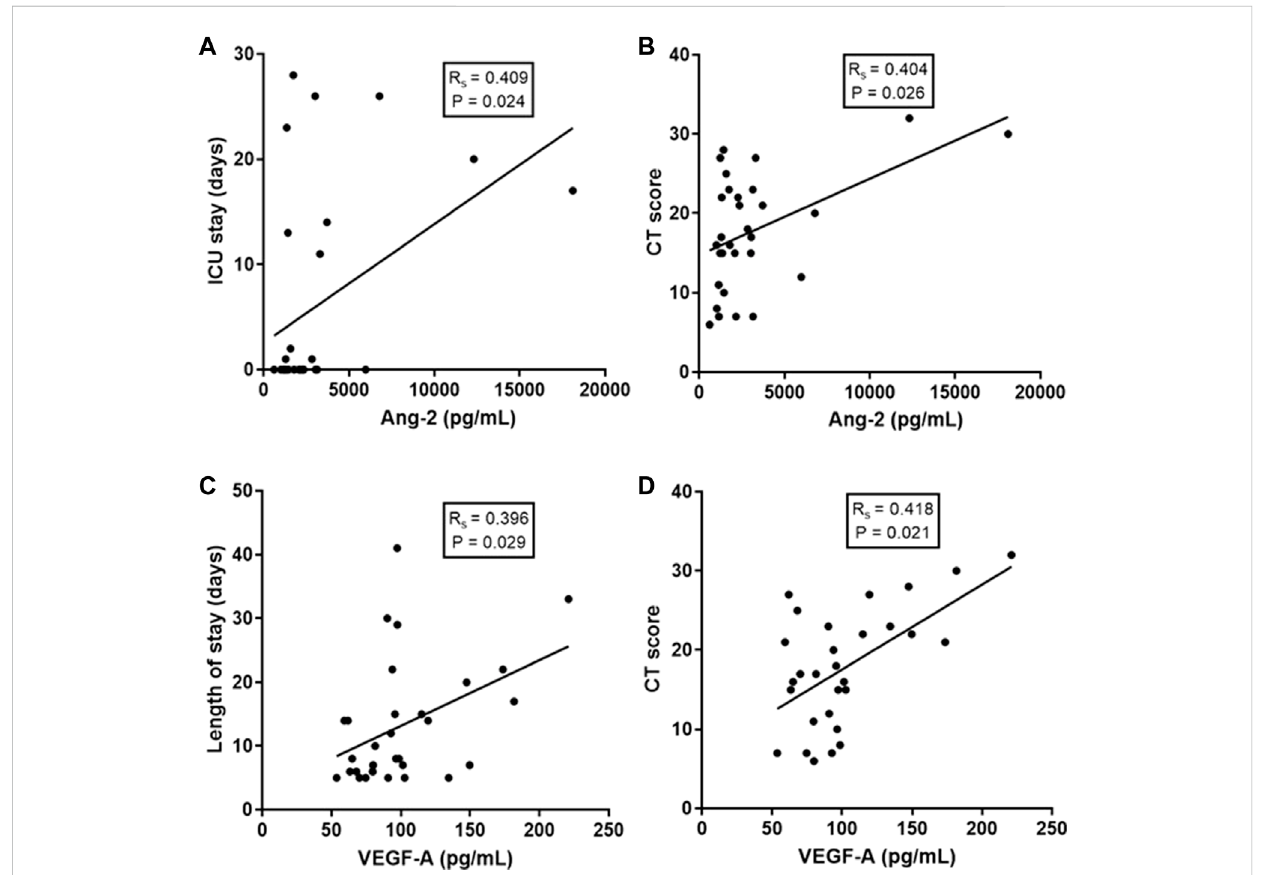
FIGURE 2 Correlations of EB integrity mediators with clinical and laboratory markers of COVID-19 severity. (A) Correlation of Ang-2 levels with ICU (intensive careunit)stay; (B) CorrelationofAng-2levelswithalungCT(computerizedtomography)score; (C) CorrelationofVEGF-Alevelswithtotalhospitallength of stay and (D) Correlation of VEGF-A levels with CT score. Spearman correlation coef fi